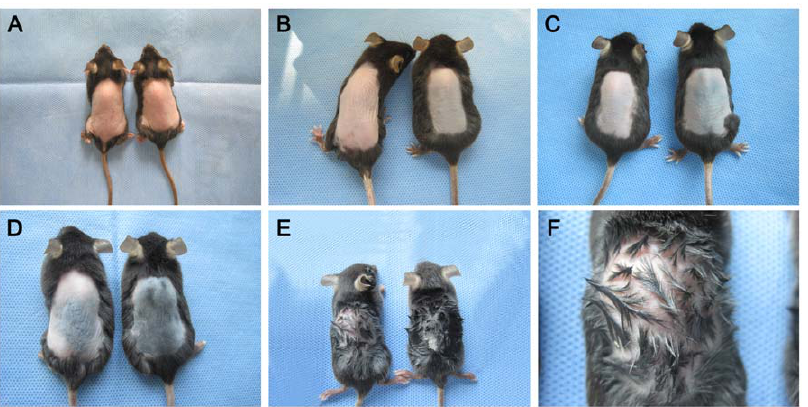
Figure 4. Inhibition of anagen induction from telogen by 6-gingerol in C57BL/6 mice. After depilation, the skin on the back was treated with vehicle (right) or 1 mg/ml 6-gingerol (left) every day for 10 days. Photographs of each animal were taken every 5 days. Compared to the vehicle- treated control, 1 mg/ml 6-gingerol can significantly inhibit anagen induction from telogen. (A) Day zero, (B) 5 days, (C) 10 days, (D) 15 days and (E) 20 days after depilation. (F) Enlarged photograph of the left-hand mouse in (E).